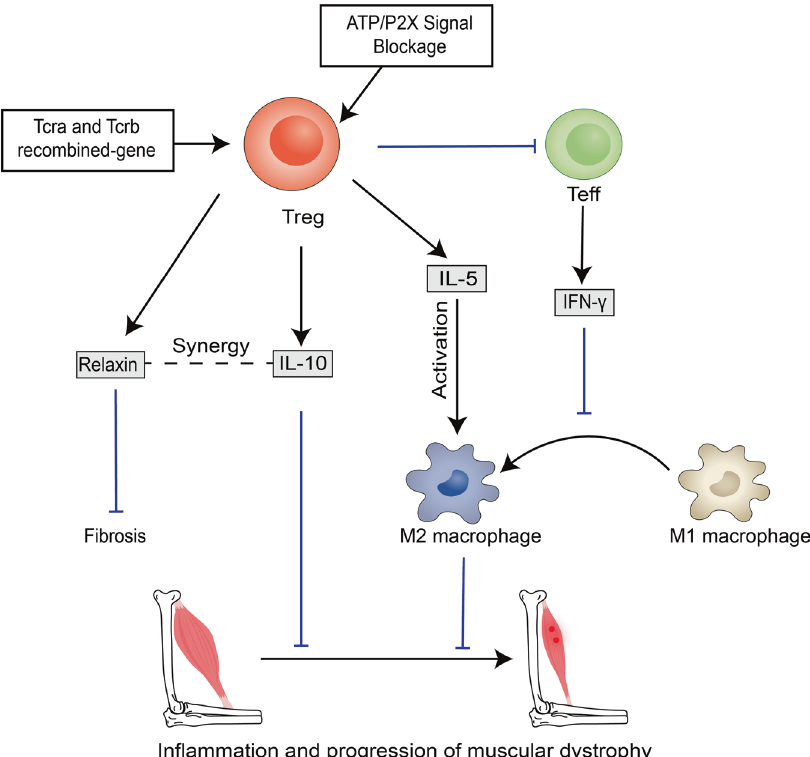
Fig. 4 Potential therapeutic targets in Treg mediated muscular dystrophy. Tregs delay the progression of DMD by releasing IL-10. In addition, Tregs suppress the in fl ammatory response by limiting the release of IFN- γ from effector T cells and releasing IL-5 which promotes the conversion of M1 macrophages to M2 macrophages. Tcra and Tcrb recombinant gene therapy and blockade of the ATP/P2X signalling pathway have potential in DMD treatment by regulating Tregs and delaying muscular dystrophy progression. DMD, Duchenne muscular